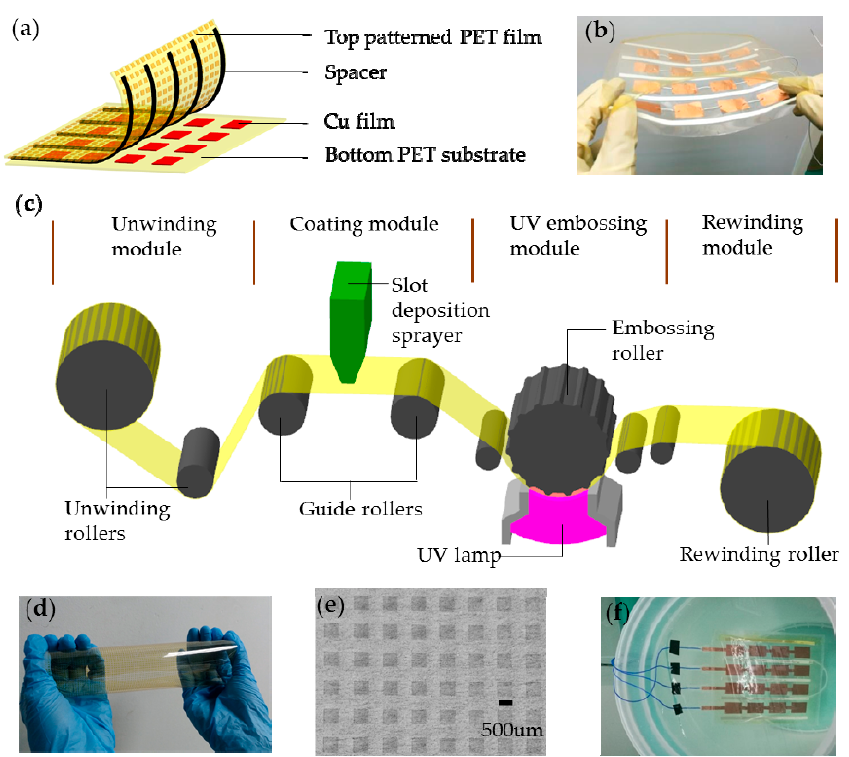
Figure 1. ( a ) Schematic diagram of the flexible TSA with micro patterns on top PET film; ( b ) Photograph of the flexible TSA sheet; ( c ) Schematic illustration of roll-to-roll UV embossing fabrication setup; ( d ) Photograph of the top patterned PET film; ( e ) Optical image of the microstructures on patterned film; ( f ) Photograph of the TSA after sealing and waterproofing treatment.